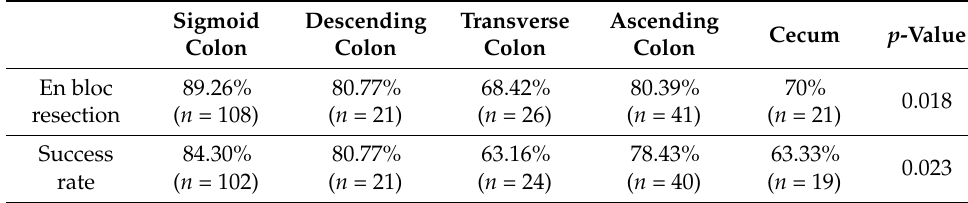
Table 2. Efficacy of ESD procedure in individual parts of the colon.